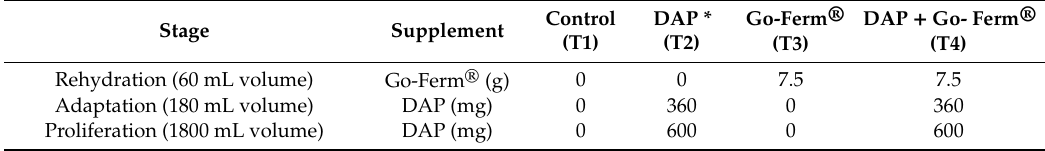
Table 2. Quantity of nutrients added during the three stages of yeast